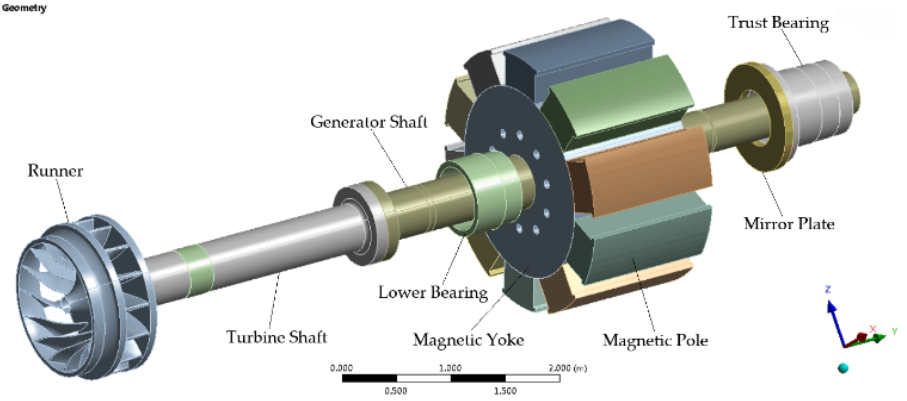
Figure 2. Solid geometry model of Shafting system.